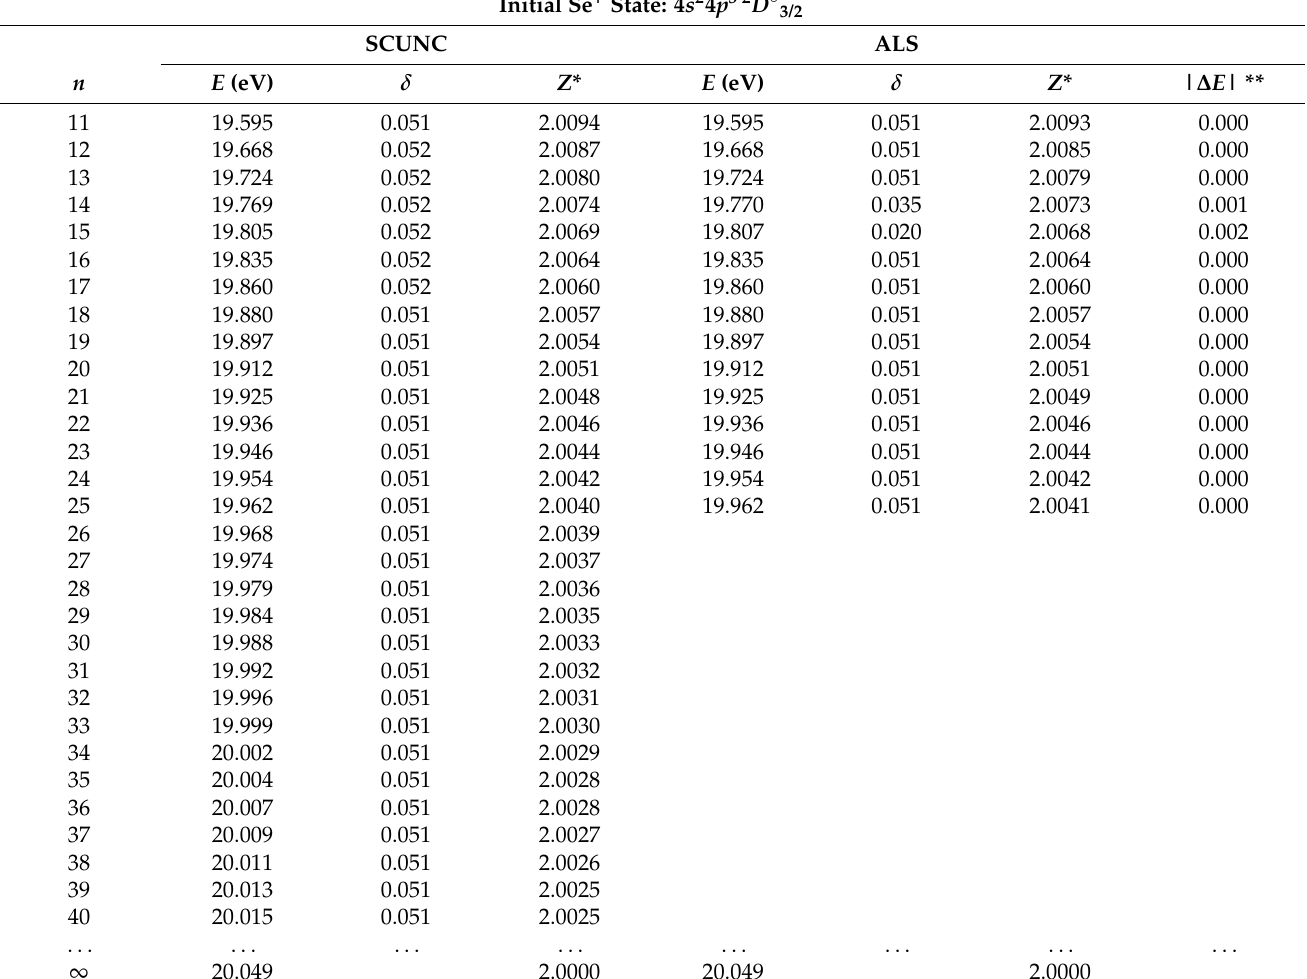
Table 9. Energy resonances ( E ), quantum defect ( δ ) and effective charge ( Z *) of the 4 s 2 4 p 2 ( 3 P 2 ) nd Rydberg series originating from the 4 s 2 4 p 3 2 D ◦ 3/2 metastable state of Se + converging to the 3 P 2 series limit in Se 2+ . The present results (SCUNC) are compared with the experimental data from ALS measurements [6]. The uncertainties in the experimental energies are stated to be ± 0.010 eV, f 1 ( 3 P 2 ; 2 D ◦ − 0.094 ± 0.042 with ν = 3/2 ) =